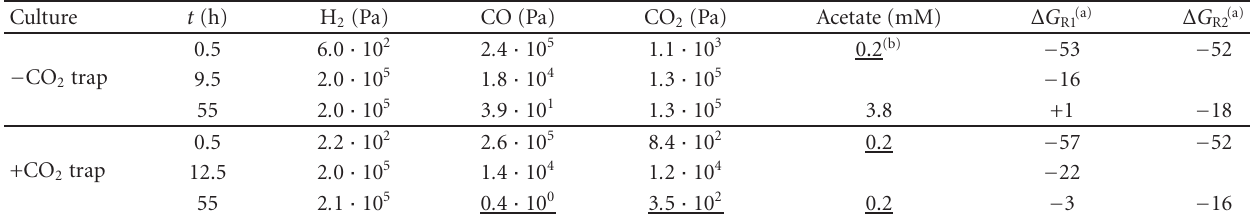
Table 1: Observed partial pressures and the calculated Gibbs free energy change of CO conversion by C. hydrogenoformans in batch culture.